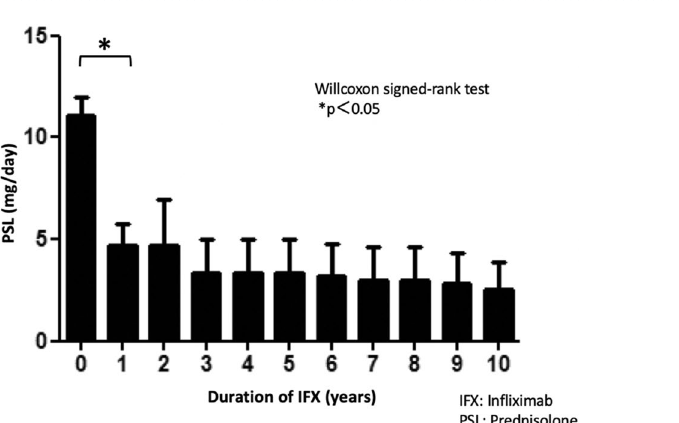
Figure 3. Best corrected visual acuity (BCVA). ( a ) The overall mean BCVA for the patients was 0.38 before IFX administration, with a significant improvement to 0.15 seen at 1 year (p = 0.0016), which was well maintained thereafter. ( b ) A comparison of the BCVA between the monotherapy and combination therapies found there was improvement in both groups after 1 year of IFX treatment (monotherapy: p = 0.058, combination therapy: p = 0.004), with the efficacy subsequently prolonged after that.